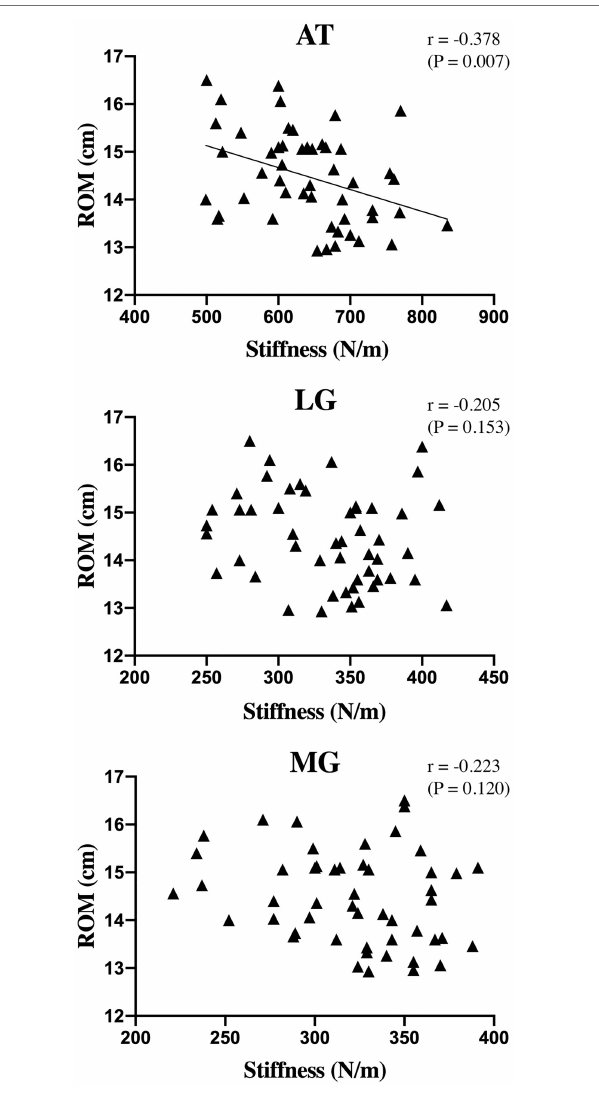
FIGURE 4 | Relationship of ankle dorsiflexion ROM and MG, LG, and AT stiffness. r, correlation coefficient; ROM, range of motion; MG, medial gastrocnemius; LG, lateral gastrocnemius; and AT, Achilles